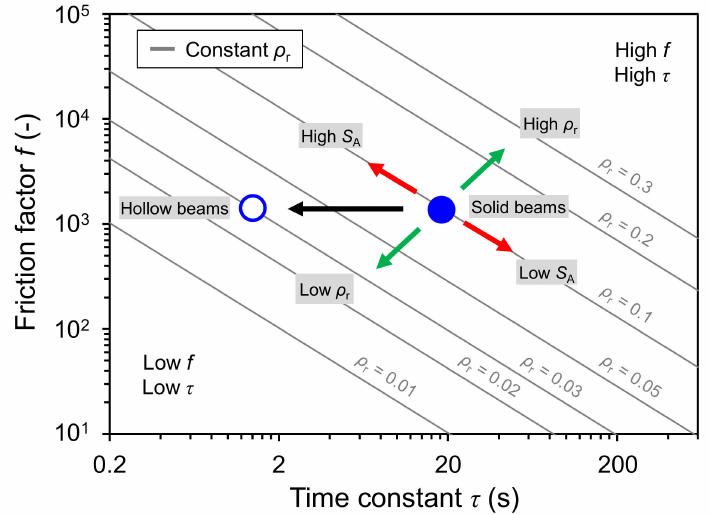
Figure 5. Figure of merit for the relationship f · τ . The friction factor f subjected to a pressure drop was plotted as a function of the time constant τ at various relative